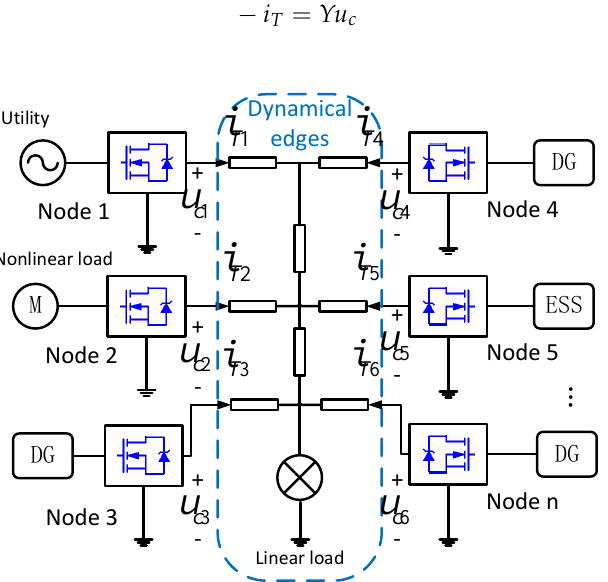
Figure 1. Structure of DC microgrid in this paper. ESS: energy storage system; and DG: distributed